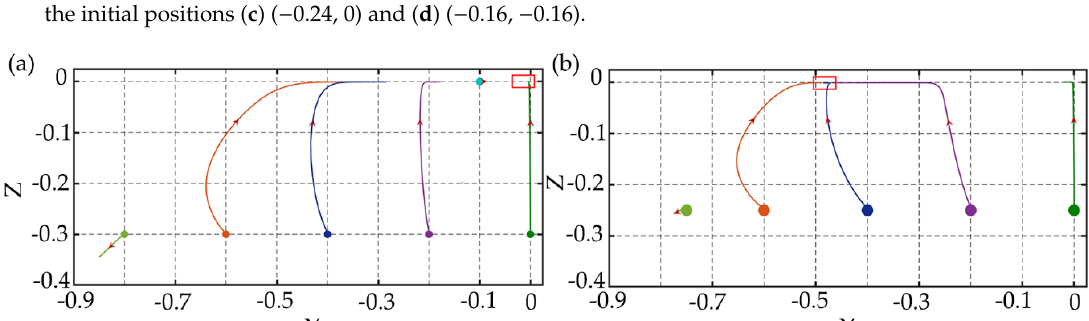
Figure 10. The migration trajectories of particles with different diameters in the channel with aspect ratio of AR = 1 / 2 under Re = 2.5 and Wi = 0.2, ( a ) d / h = 0.15; ( b ) d / h = 0.30. The red boxes in the figures are the predicted particle focusing equilibrium positions. The maximum simulation time in the figures is 1,200,000 dimensionless time units.